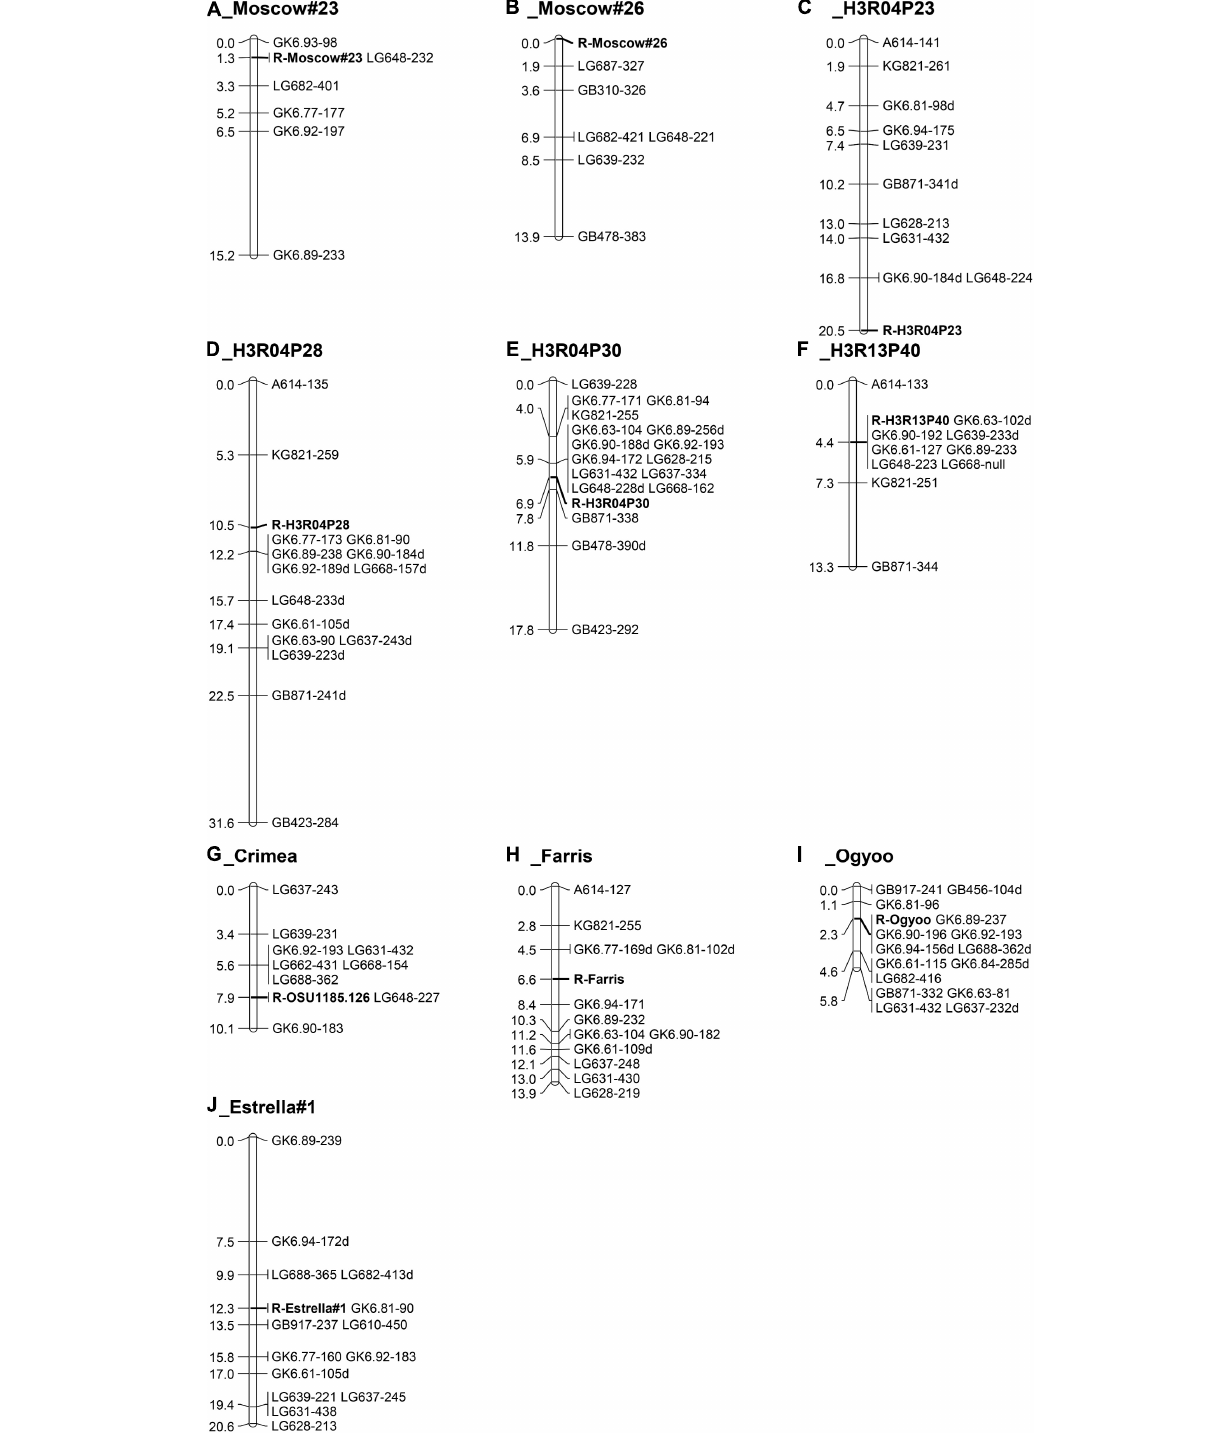
Frontiers in Plant Science |